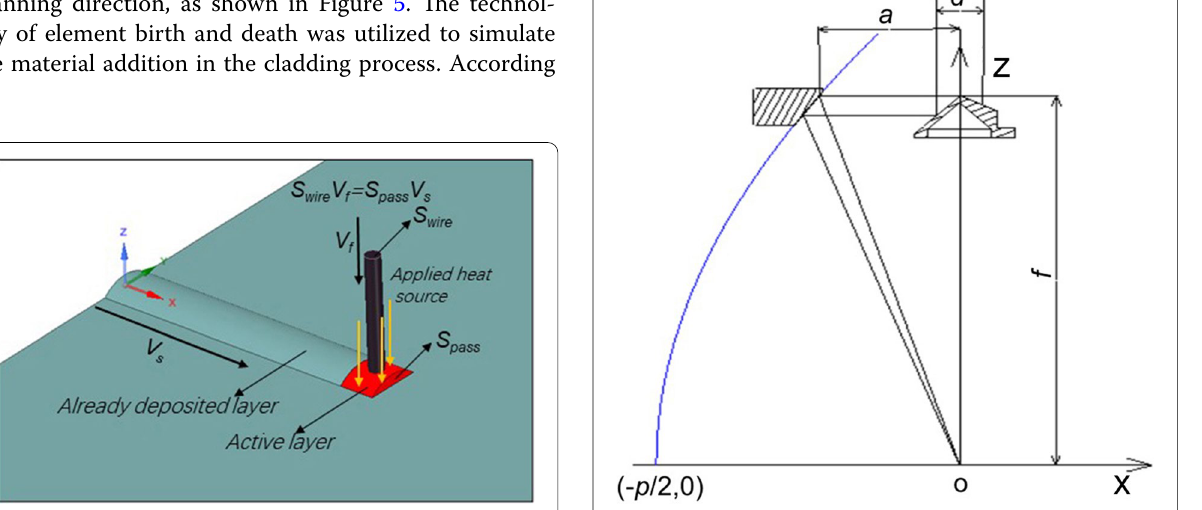
Figure 5 Technology of element birth and death Figure 6 Schematics of transmission of three-beam laser